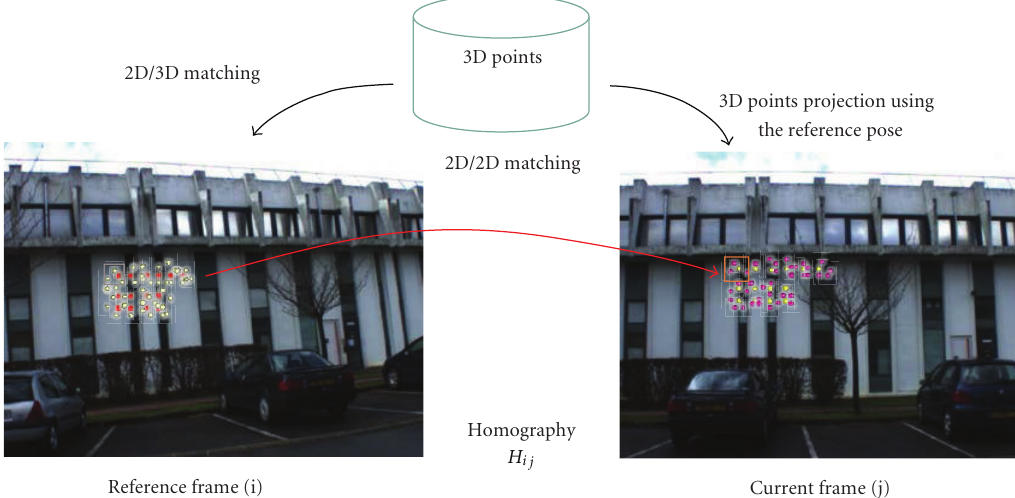
Figure 4: Automated initialization